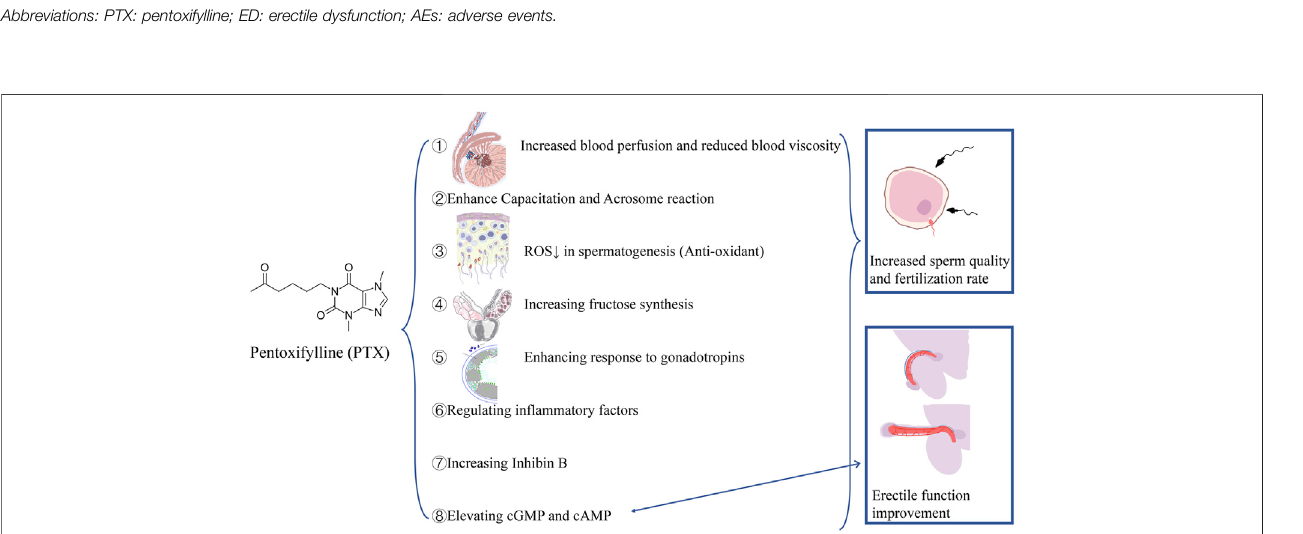
Frontiers in Pharmacology |